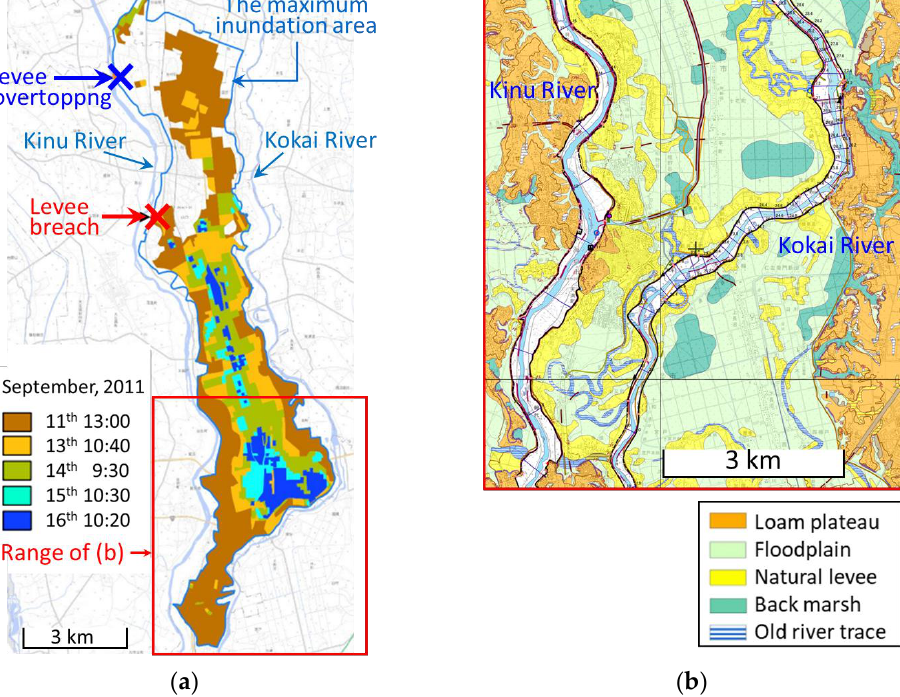
Figure 9. Flooding in closed floodplain; ( a ) time variation in inundation area and ( b ) south end topography of closed floodplain.